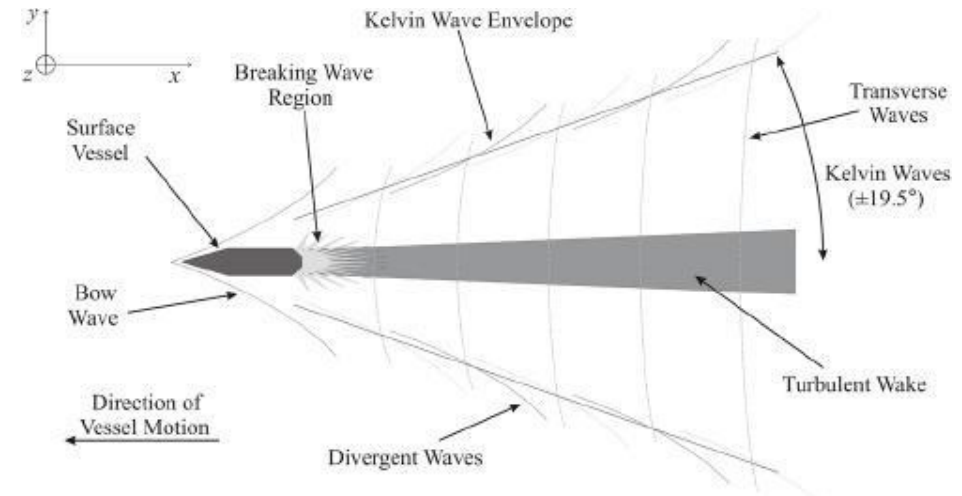
Figure 3. Sketch of Kelvin waves and turbulent wake from a sailing ship.